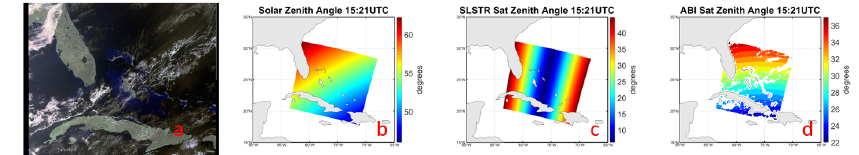
Figure 3. ( a ): SLSTR daytime false color infrared image of the eastern tropical North Atlantic Ocean coast region on 1 January 2020, 15:21:14 UTC. ( b ): Solar zenith angles data at the same time. ( c ): Corresponding SLSTR satellite zenith angles. ( d ): Corresponding ABI satellite zenith angles, only the points with available ABI matched up pairs are shown. Remote Sens. 2020 , 12 , x FOR PEER REVIEW